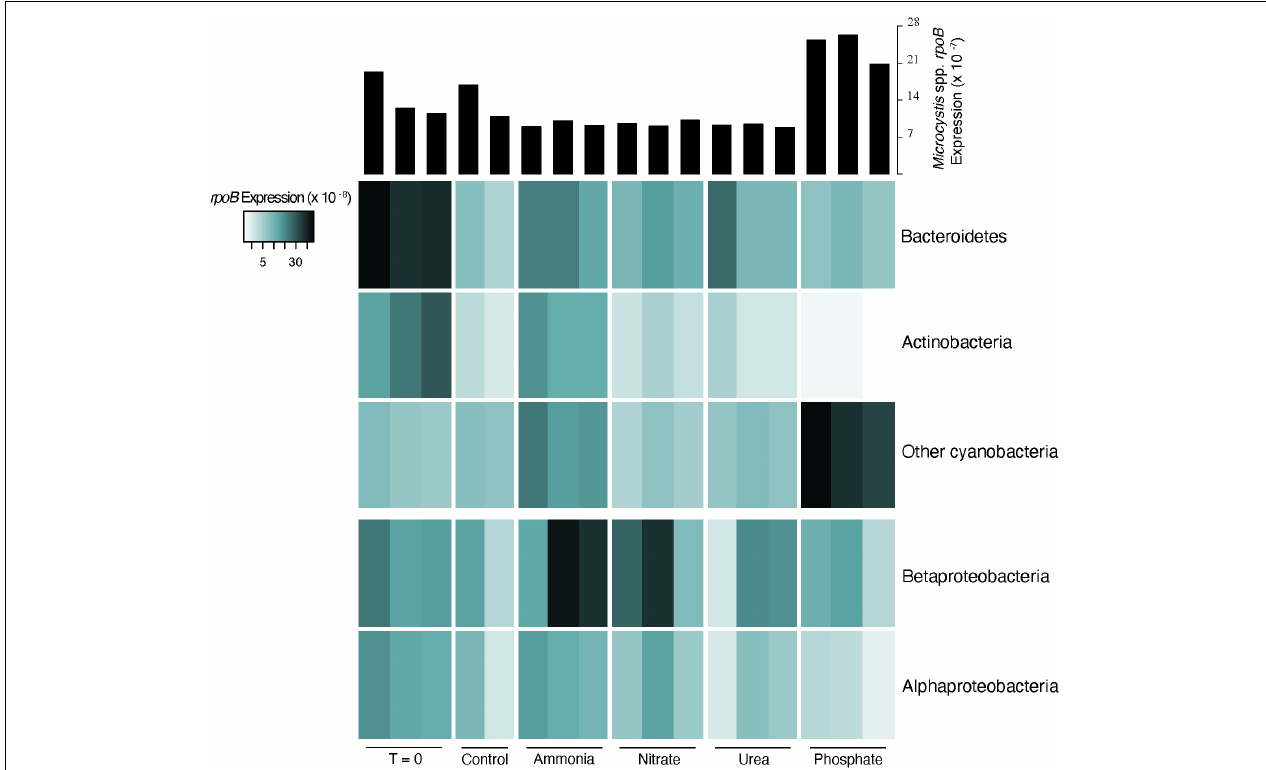
FIGURE 2 | Heatmap of normalized expression of the DNA-dependent RNA polymerase ( rpoB ) of dominant phyla (top three) and classes (bottom two) in co-occurring heterotrophic microbial community. Expression was normalized to the library size for each sample. Histograms at the top describe the transcriptional response of Microcystis spp. rpoB for